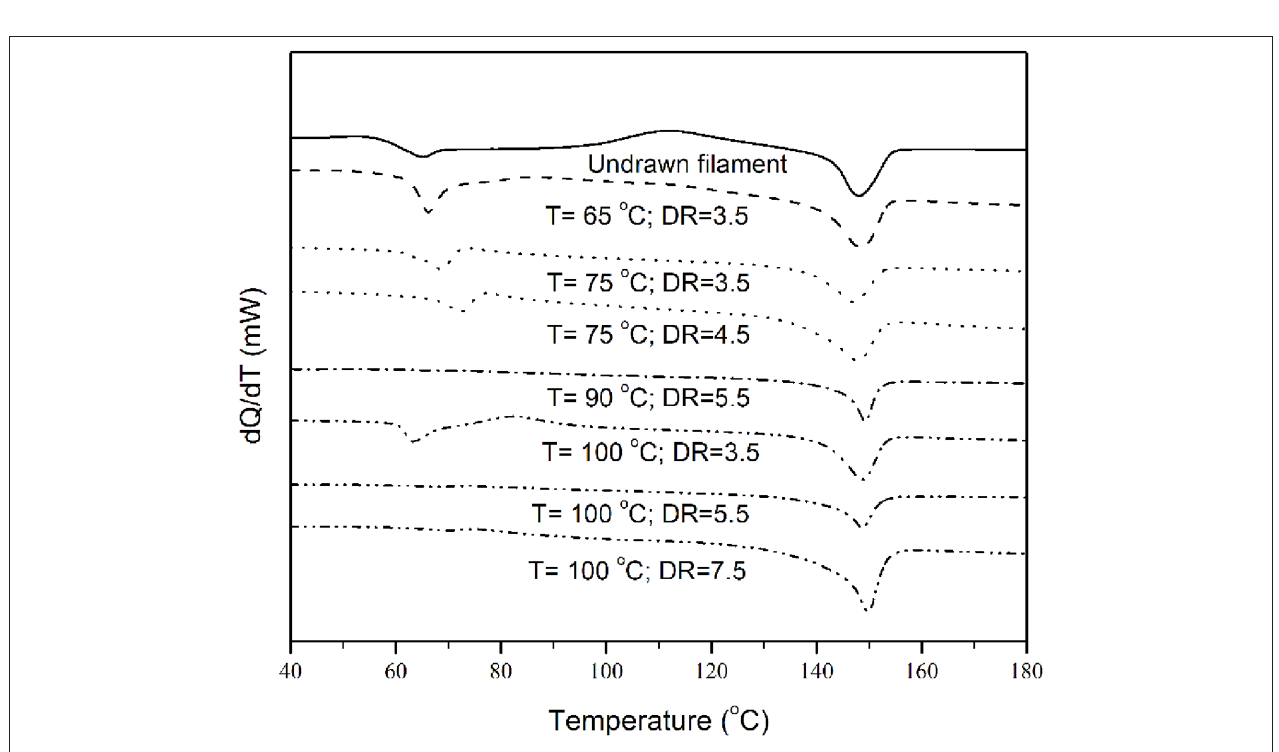
FIGURE 2 | DSC heating scans for the PLA-based undrawn filament and the filaments drawn at different draw ratios and drawing temperatures.